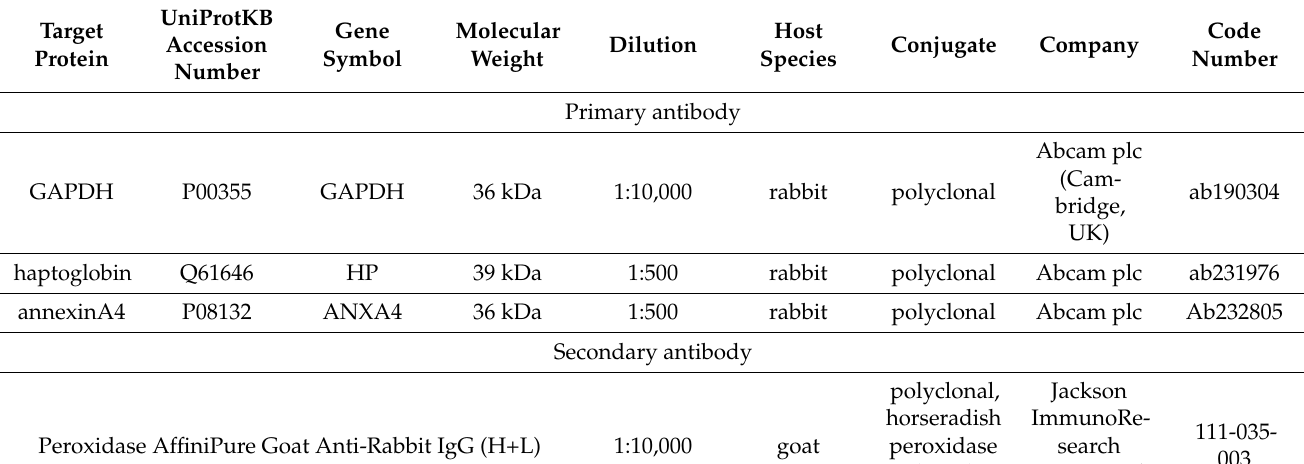
Table 2. List of specific immunoblot antibodies utilized in the western blotting validation